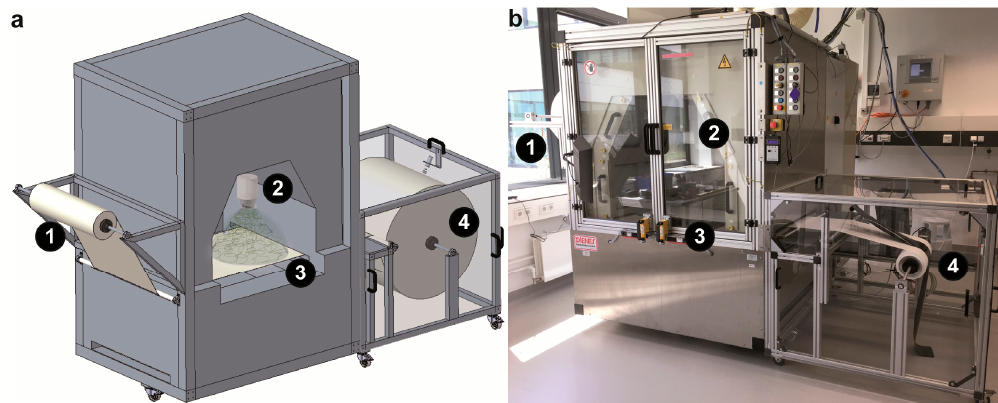
Figure 3. Continuous production of spider silk nanofiber meshes in a roll-to-roll process. ( a ) Model and ( b ) photo of polyamide support bracket (1) and winding unit (4) mounted at the centrifugal electrospinning device. The polyamide (PA) support is dragged by a step motor connected to the winding shaft (4) through the spinning chamber and over the collector (3), where it is coated with nanofibers by the spinneret (2).